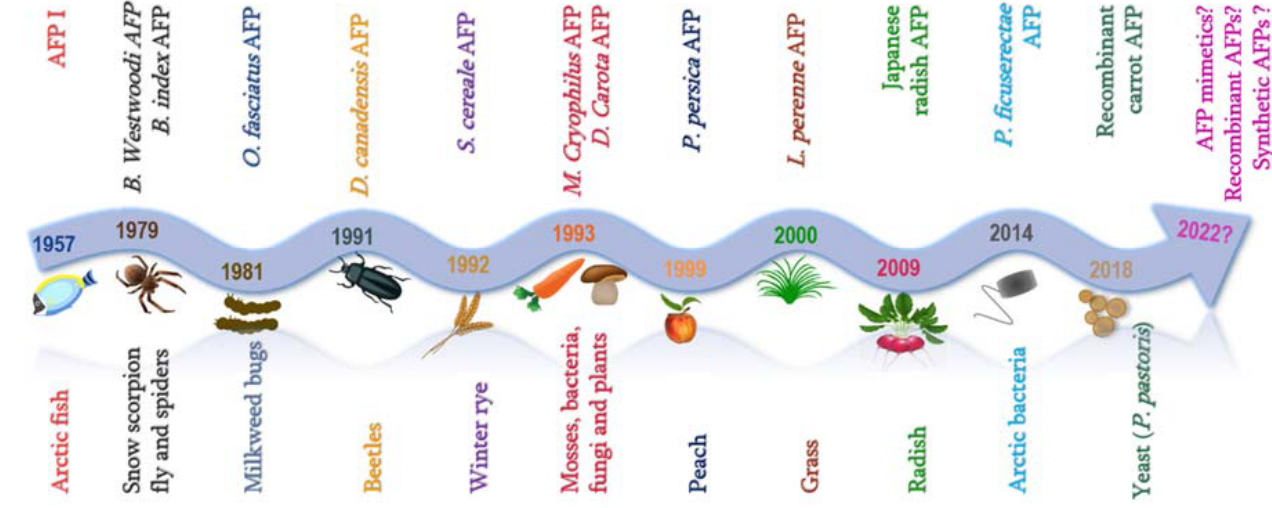
Figure 1. Trend in the discovery of Antifreeze proteins from diverse biological sources. AFPs are impermeable CPAs which have also been referred to as thermal hystere- sis proteins and ice structuring or binding proteins based on their mechanism of action (Figure 2) which is in their ability to reduce or inhibit ice crystal growth by binding to ice surfaces [15]. This binding activity inhibits IR by causing the freezing temperature to be suppressed below the melting point in a non-colligative manner in a process termed large thermal hysteresis [16]. AFP binding also results in melting hysteresis where the melting temperature is raised above the melting point. The combination of these pro- cesses is termed thermal hysteresis (TH), without which organisms would not thrive in frigid environments [16]. The interaction between AFPs and water and ice crystals at low temperatures to inhibit ice formation and growth has been studied and confirmed with diverse methodologies including quantum filtering-spin exchange nuclear magnetic resonance (NMR) [17] microfluidic experimentation [18], NMR microimaging and the more recent site-directed spin labelling performed by monitoring the activity of spin-labelled AFPs at low temperatures with electron paramagnetic resonance (EPR) and cryo-photo microscopy